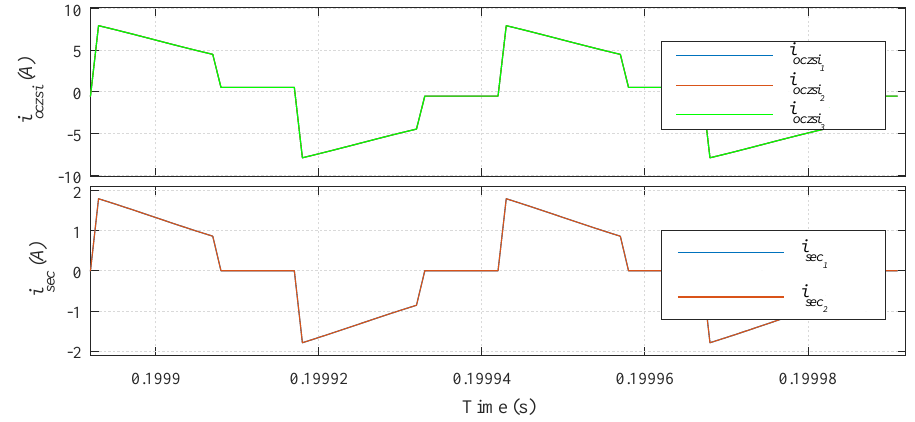
Figure 7. Simulation results: CZSI modules output current i oczsi currents i sec and i sec under balanced 2 1